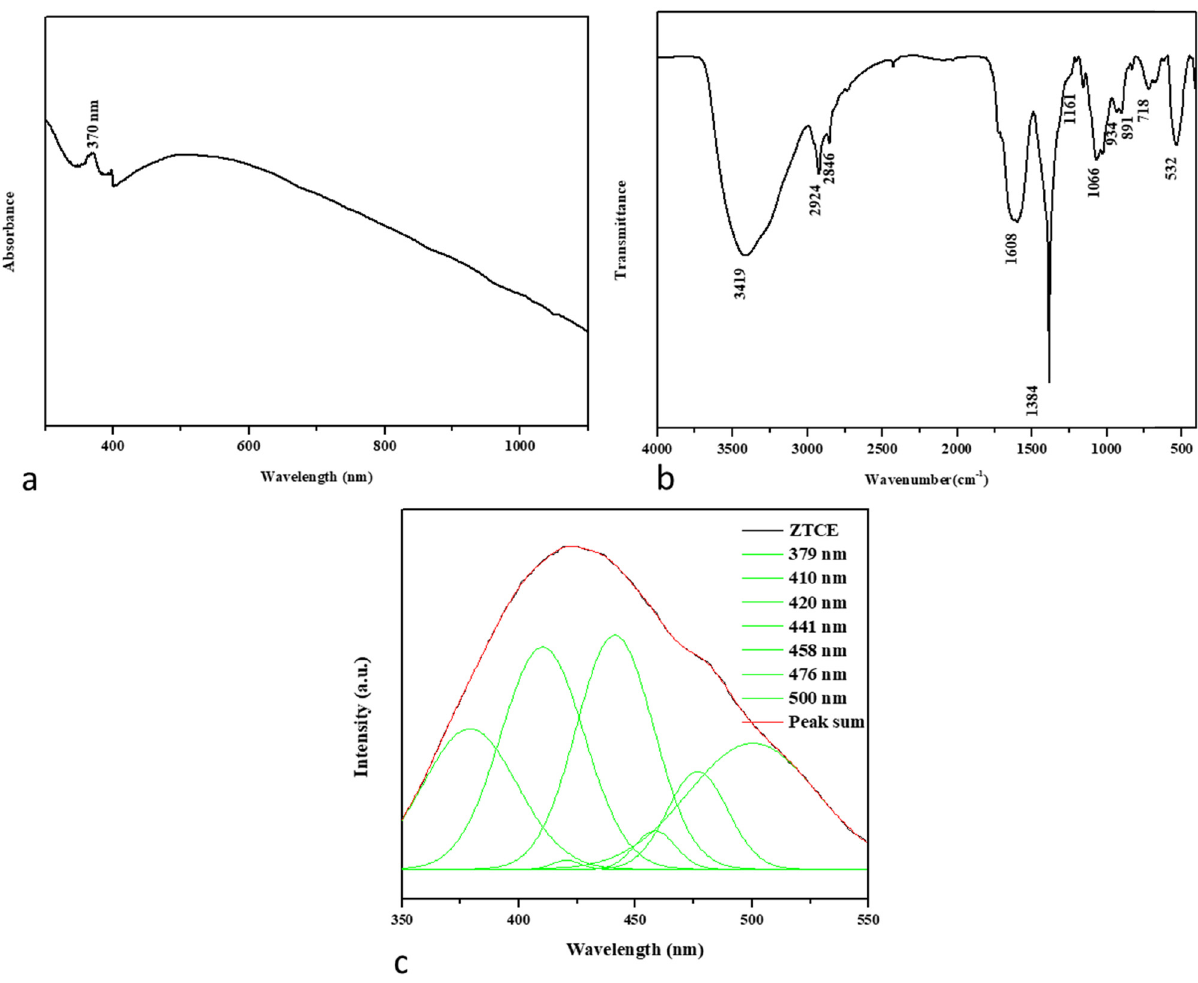
Figure 4: An analysis of ZnO – TiO 2 – chitosan – escin bio - nanocomposites by ( a ) UV absorbance, ( b ) FTIR spectra, and ( c ) PL spectra. These data represented the results of experiments performed in